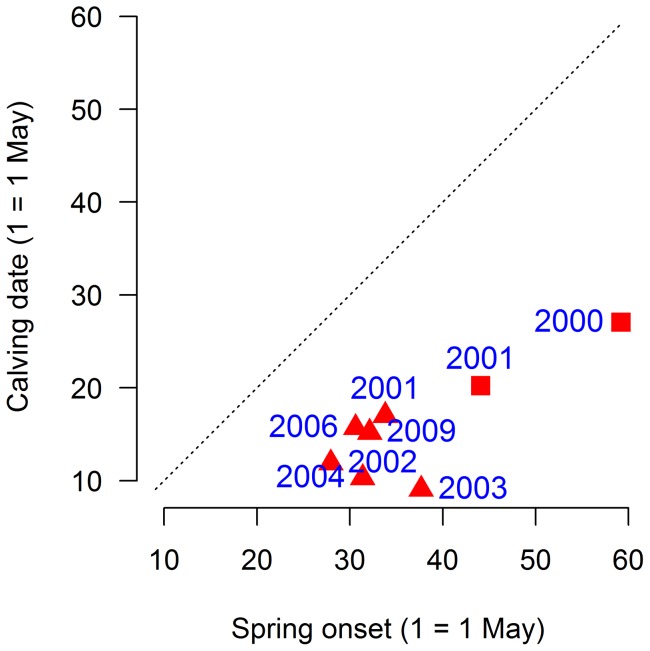
The relationship between calving date and spring onset for two herds with individually marked females.Squares are data from Spalca [37] and triangles are data from Njeaiddan [39]. The dashed line indicates the 1∶1 relationship.